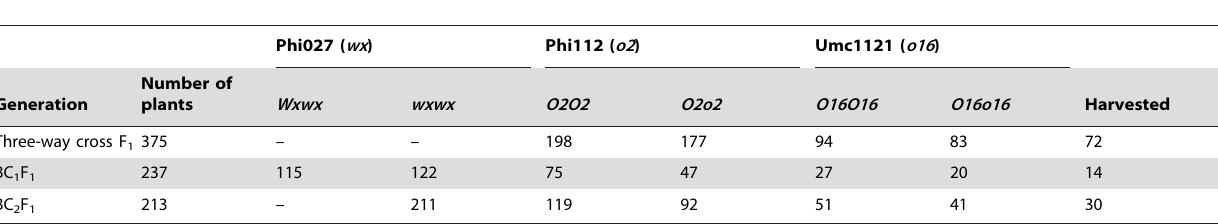
Table 2. Foreground selection for 3 segregating population using SSR markers.